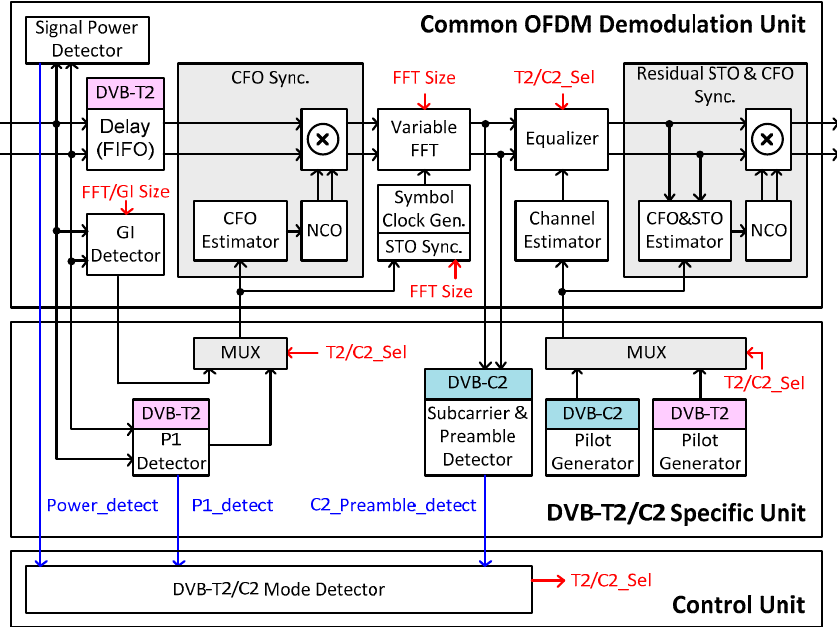
Figure 9. Block diagram of the proposed DVB-T2/C2 demodulator.